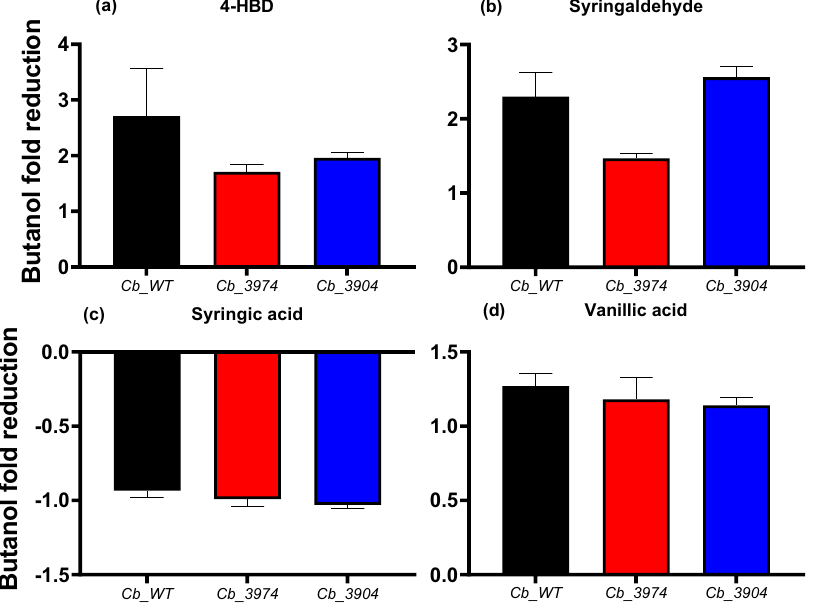
Figure 10. Fold reductions in butanol concentrations as a measure of relative toxicities of 4-HBD, syringaldehyde, syringic acid, and vanillic acid on Cb _3974, _3904, and _wild